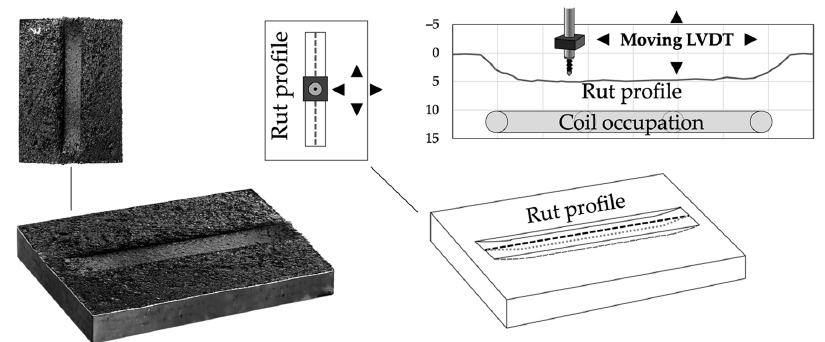
Figure 6. Rut profile measuring